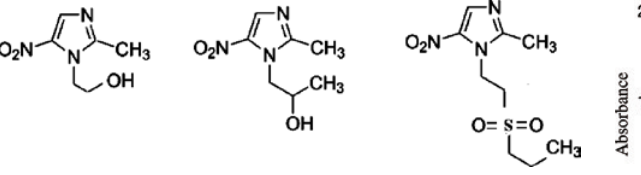
Figure 1: Chemical structure of metronidazole, secnidazole and